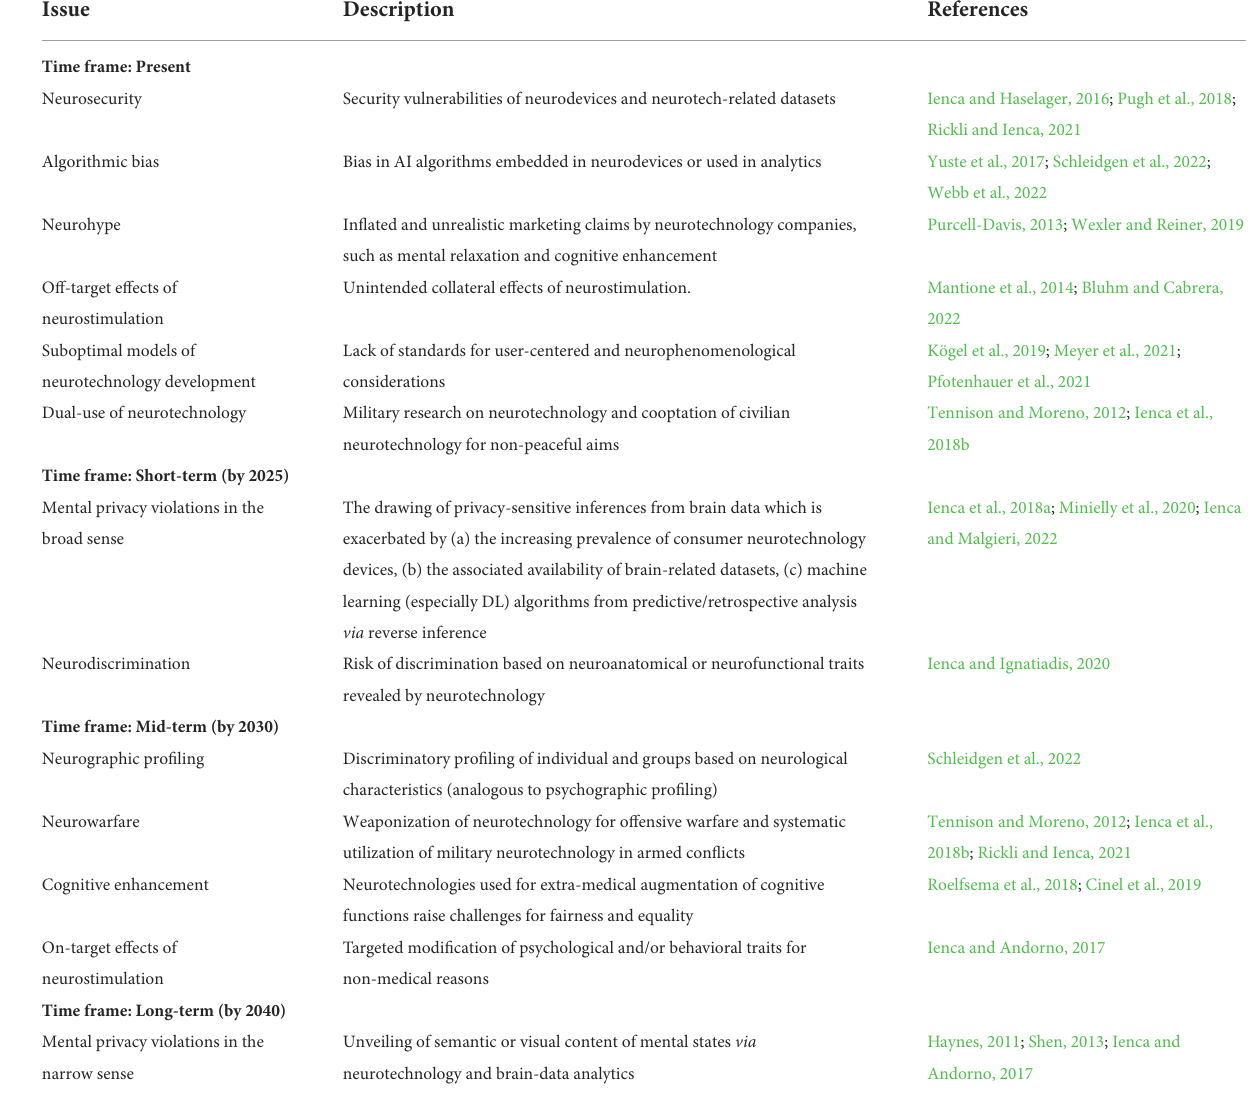
TABLE 1 Foresight map of neurotechnology-related ethical and societal